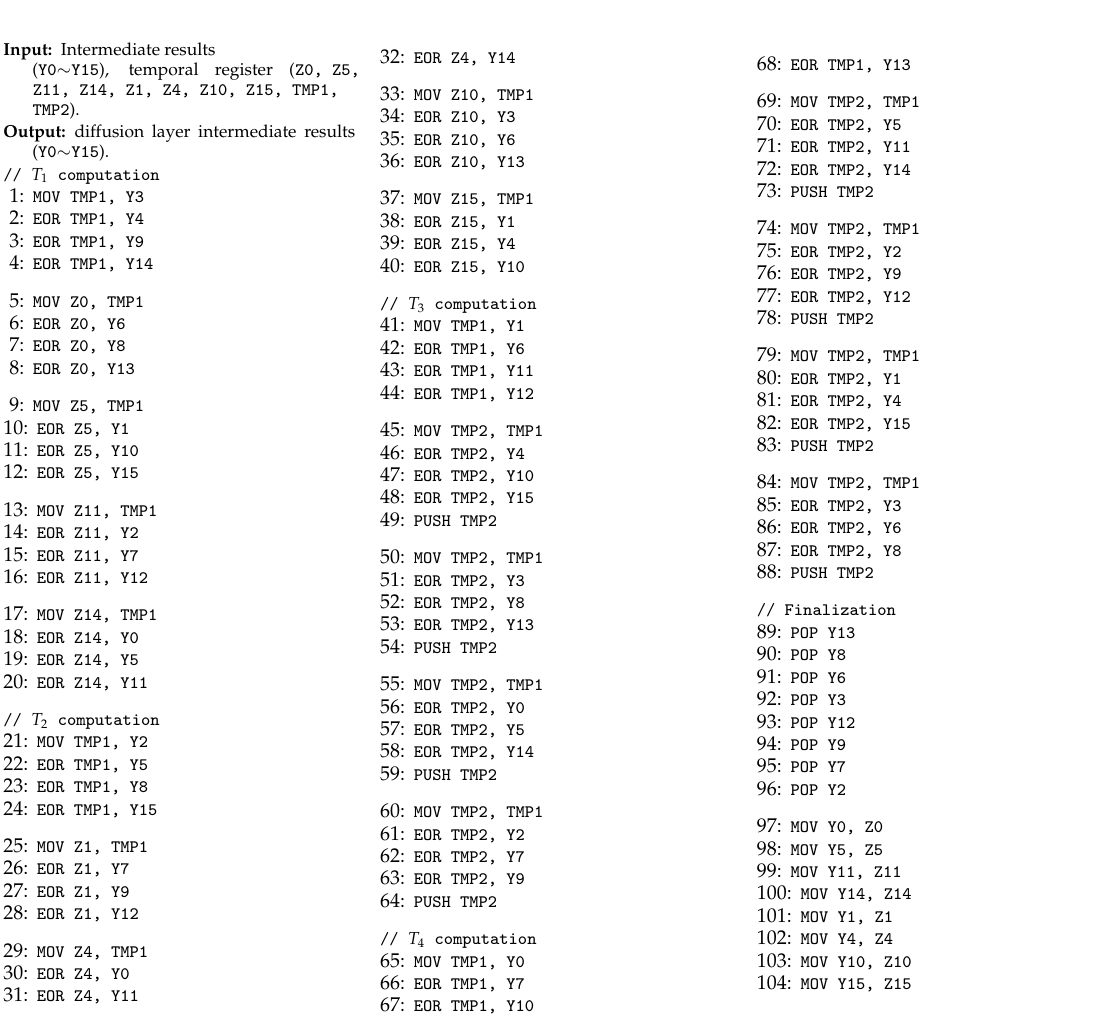
Algorithm 3 Proposed implementation of 8-bit optimized diffusion layer in a source code